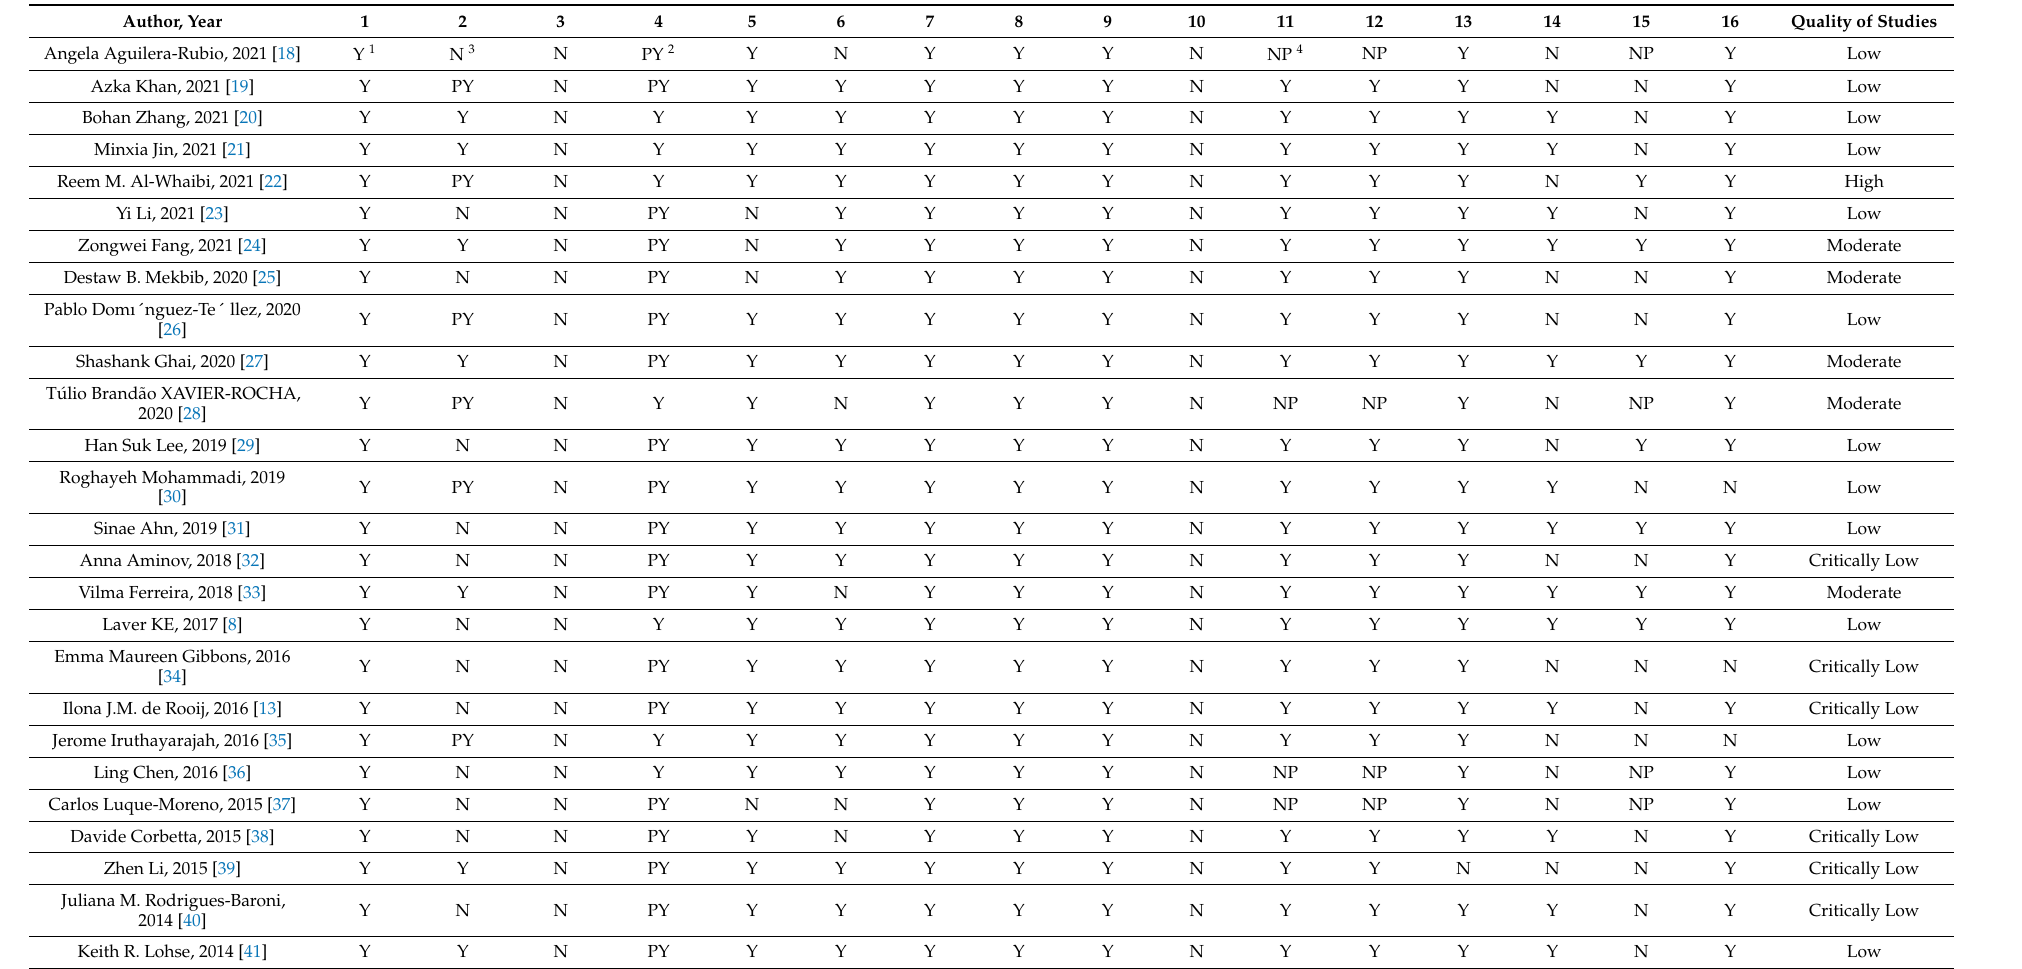
Table 3. Results of the Assessing the Methodological Quality of Systematic Reviews 2 tool quality evaluation (n =